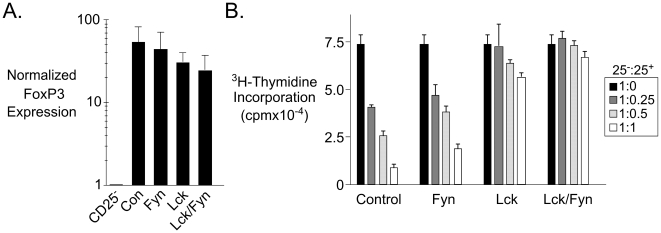
Retention of FoxP3 but abrogation of in vitro suppression in Lck-mutant regulatory cells.A. Real-time PCR analysis of FoxP3 expression in CD25+CD4+ T cells from mice of the indicated genotypes. Expression values were calculated relative to HPRT as an internal standard using the ΔΔCt method [76], and with normalization to the expression value obtained for the CD25− sample from control mice. B. The graphs show 3H-Thymidine uptake in cultures comprised of CD25− and CD25+ T cells at the stated ratios from mice of the indicated genotypes. Lymph node cells from mice of the indicated genotypes were flow-sorted then stimulated with soluble anti-CD3 and anti-CD28 in the presence of irradiated wild-type splenic accessory cells.